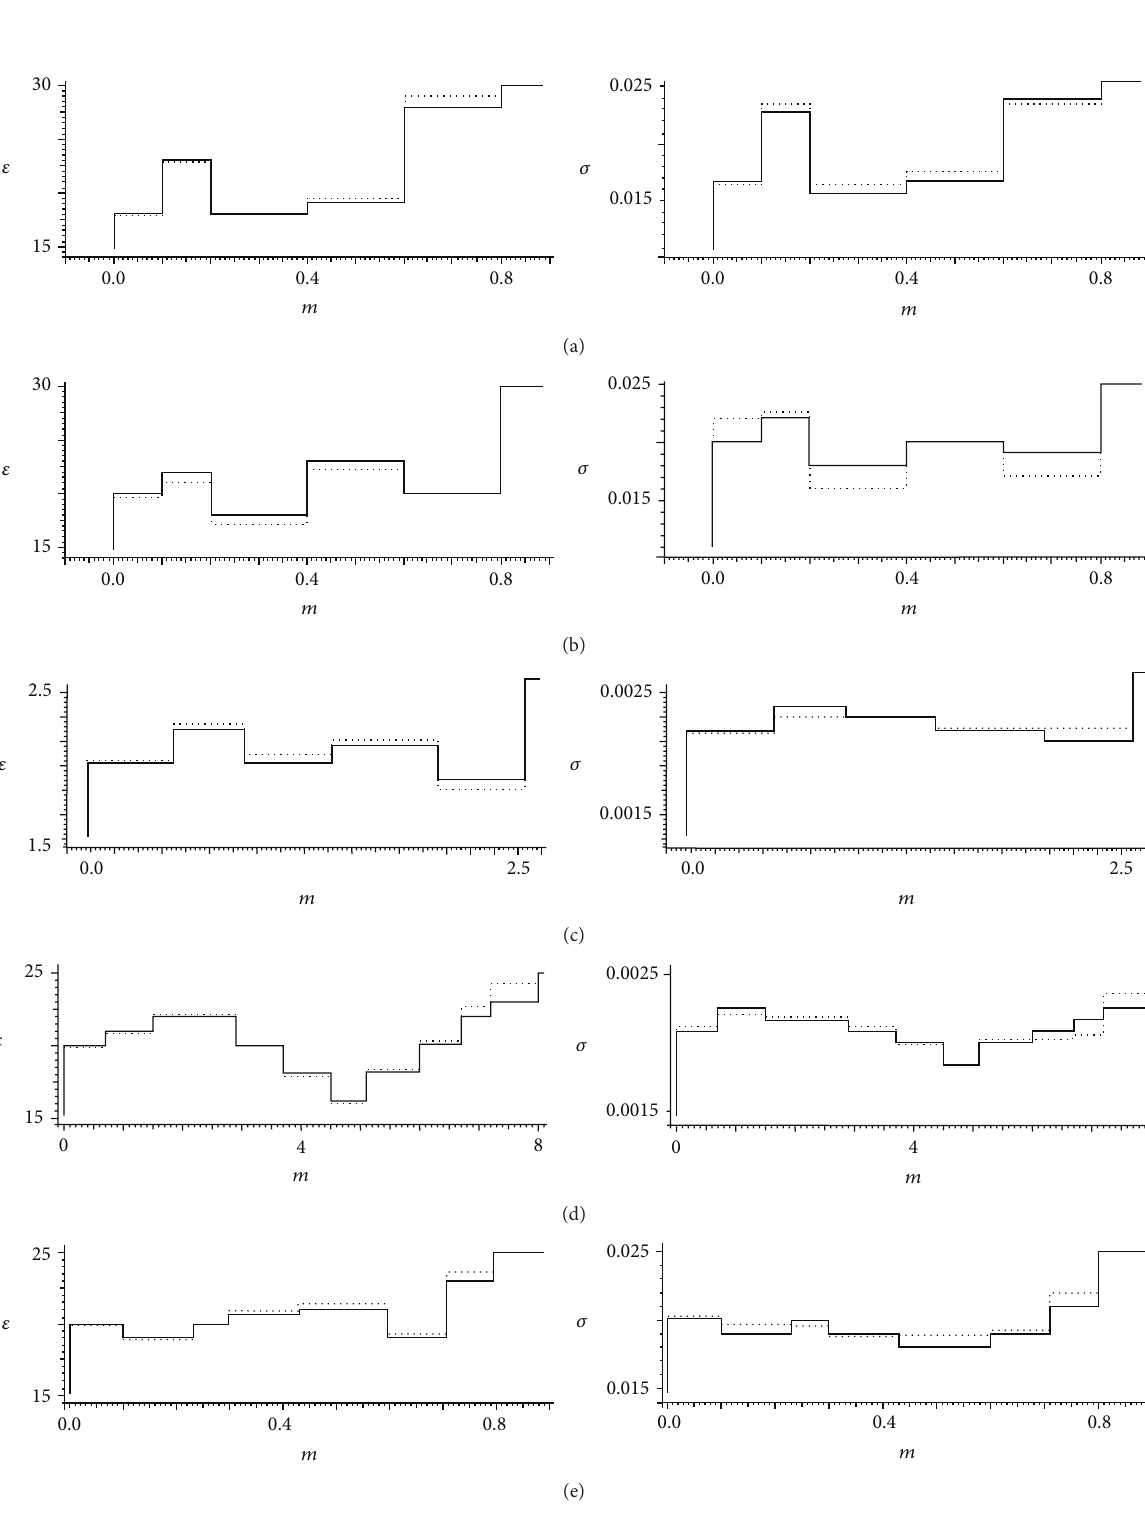
Figure 4: The examples or recovery 𝜀 and 𝜎 : (a) model of the medium 1, (b) model of the medium 2, (c) model of the medium 3, (d) model of the medium 4, and (e) model of the medium 5. The exact solution is shown by the continuous line. The recovered solution is shown by the dotted line. For all the examples 𝑃 = 20